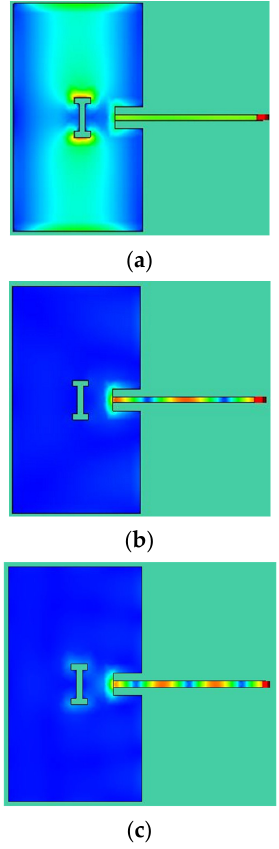
Figure 5. Current distribution of the proposed patch antenna. ( a ) Fundamental frequency. ( b ) Second-harmonic frequency. ( c ) Third-harmonic frequency.